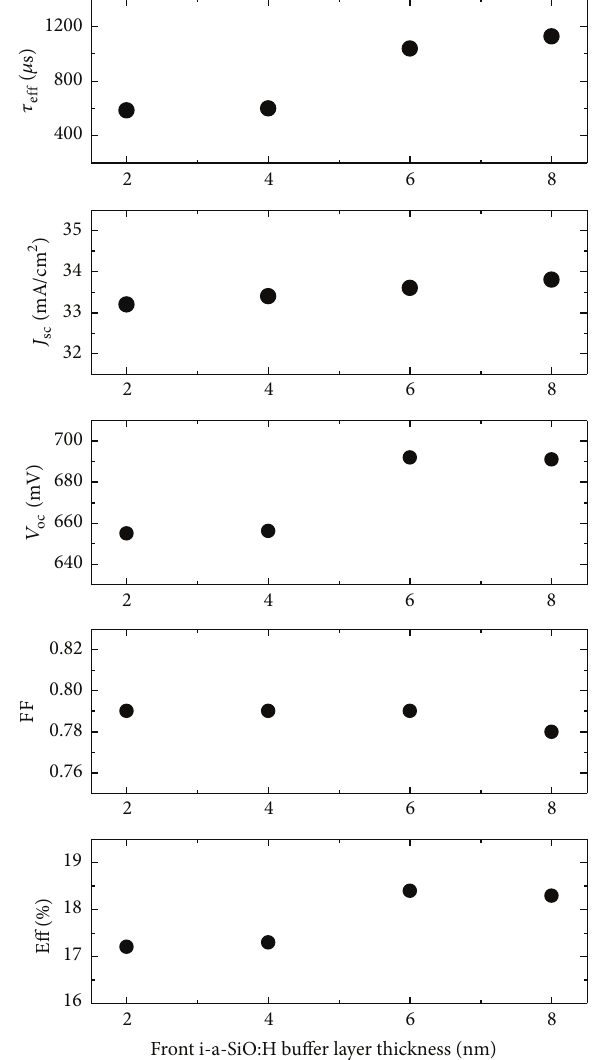
Figure 3: PV parameters and 𝜏 buffer layer